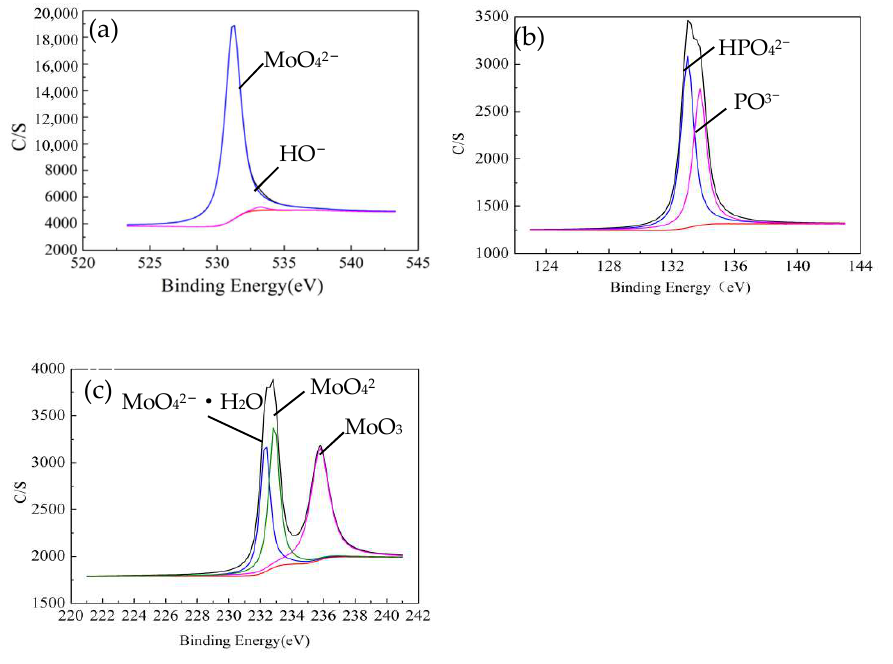
Figure 6. The high-resolution XPS spectrum of ( a ) O2p, ( b ) P2p, and ( c ) Mo2p. Table 6. Element-binding energy and percentage content of passivation film. Chemical